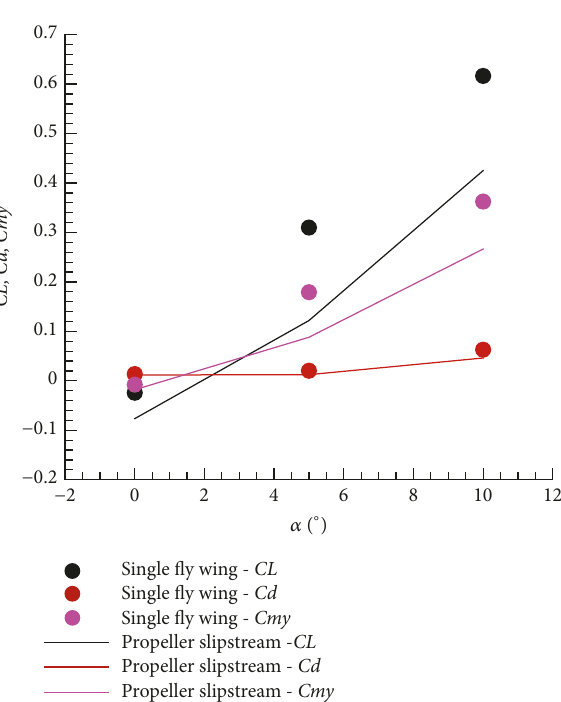
Figure 19: Steady aerodynamics-lift coefficients Cl , drag coefficients Cd , and pitching moment coefficients Cmy